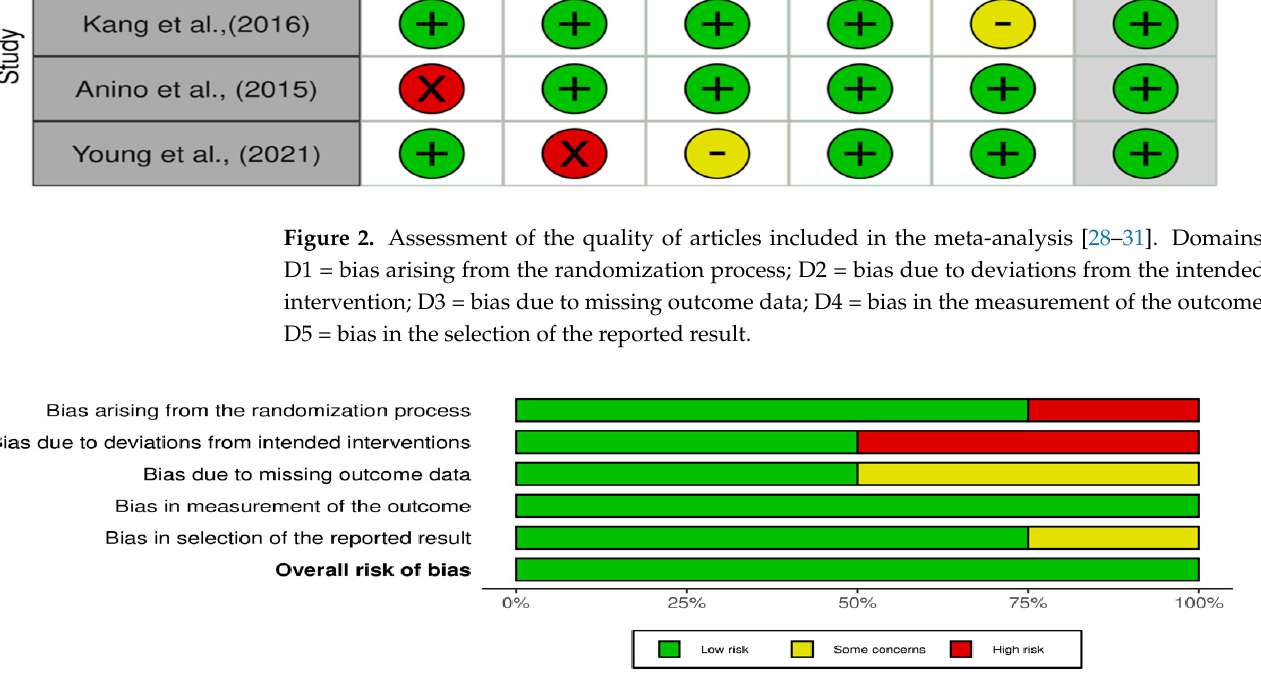
Figure 3. Assessment of the quality of articles (percentages) included in the meta-analysis